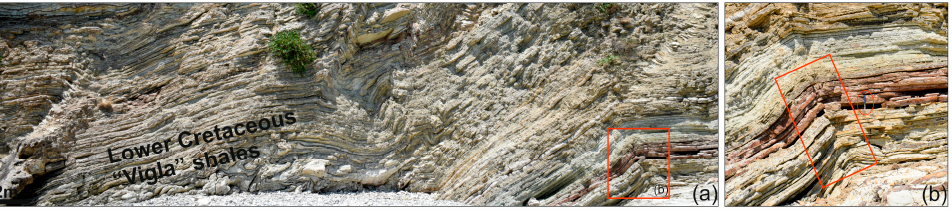
Figure 4. ( a ) Representative section in Kastos Island of Lower Cretaceous “Vigla” shales from where most of the samples were selected. Red box marks the position of ( b ).